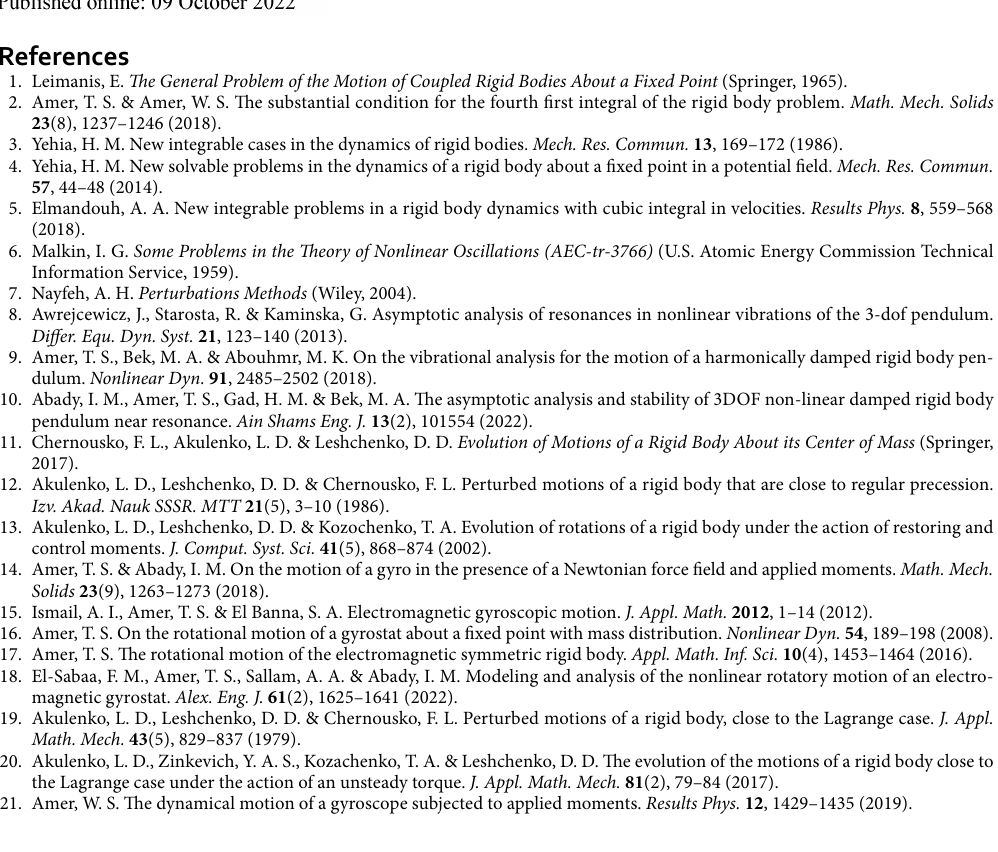
50, 100, 150 ) kg m 2 s − 1 =